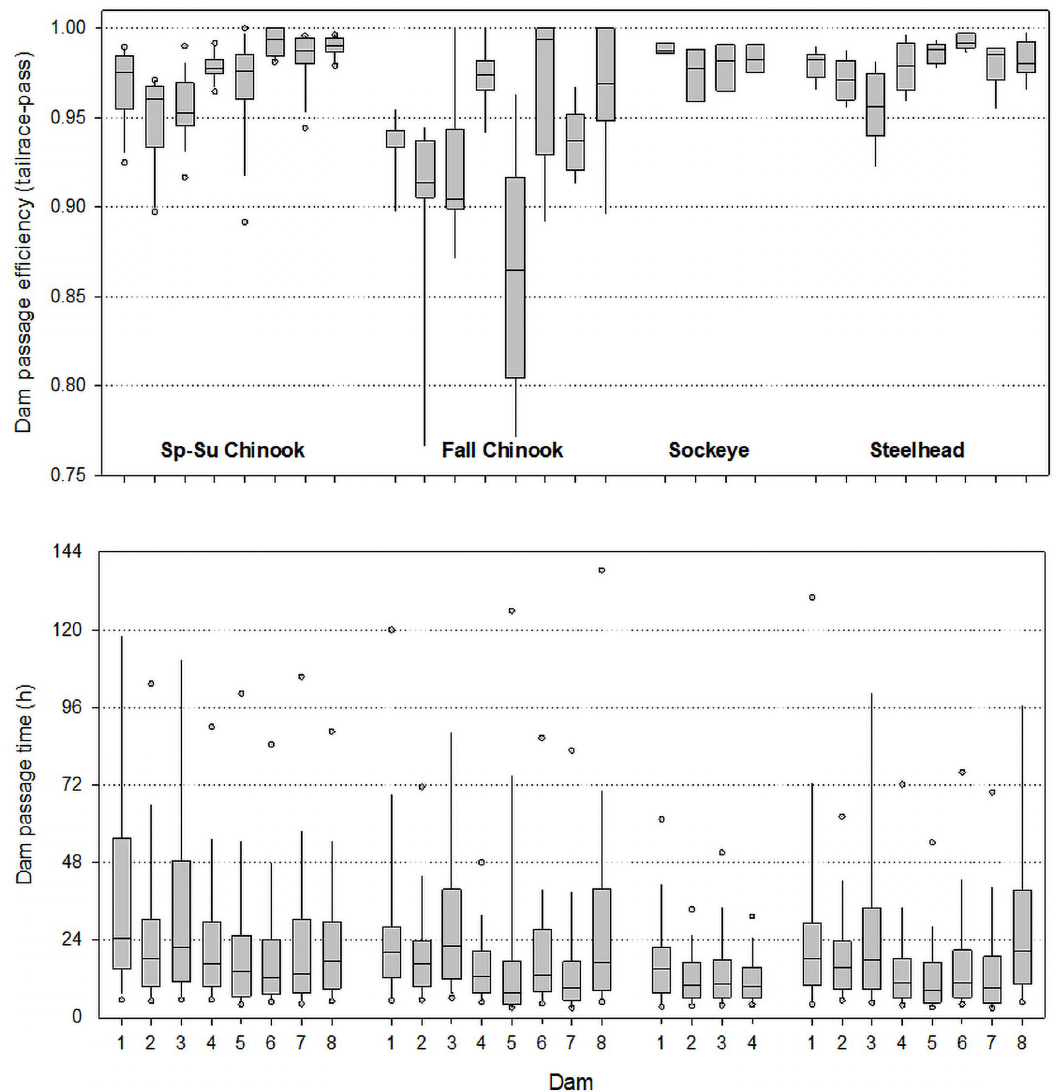
Fig 2. Distributions of annual dam passage efficiency estimates (top) and individual fish passage times (h) from first tailrace detection to pass a dam (bottom) for radio-tagged adult salmon and steelhead at eight study dams. Dams are ordered from downstream to upstream: Bonneville, The Dalles, John Day, McNary, Ice Harbor, Lower Monumental, Little Goose, and Lower Granite. Box plots show 5 th , 10 th , 25 th , 50 th , 75 th , 90 th and 95 th percentiles (two 95 th percentile values not shown were > 144